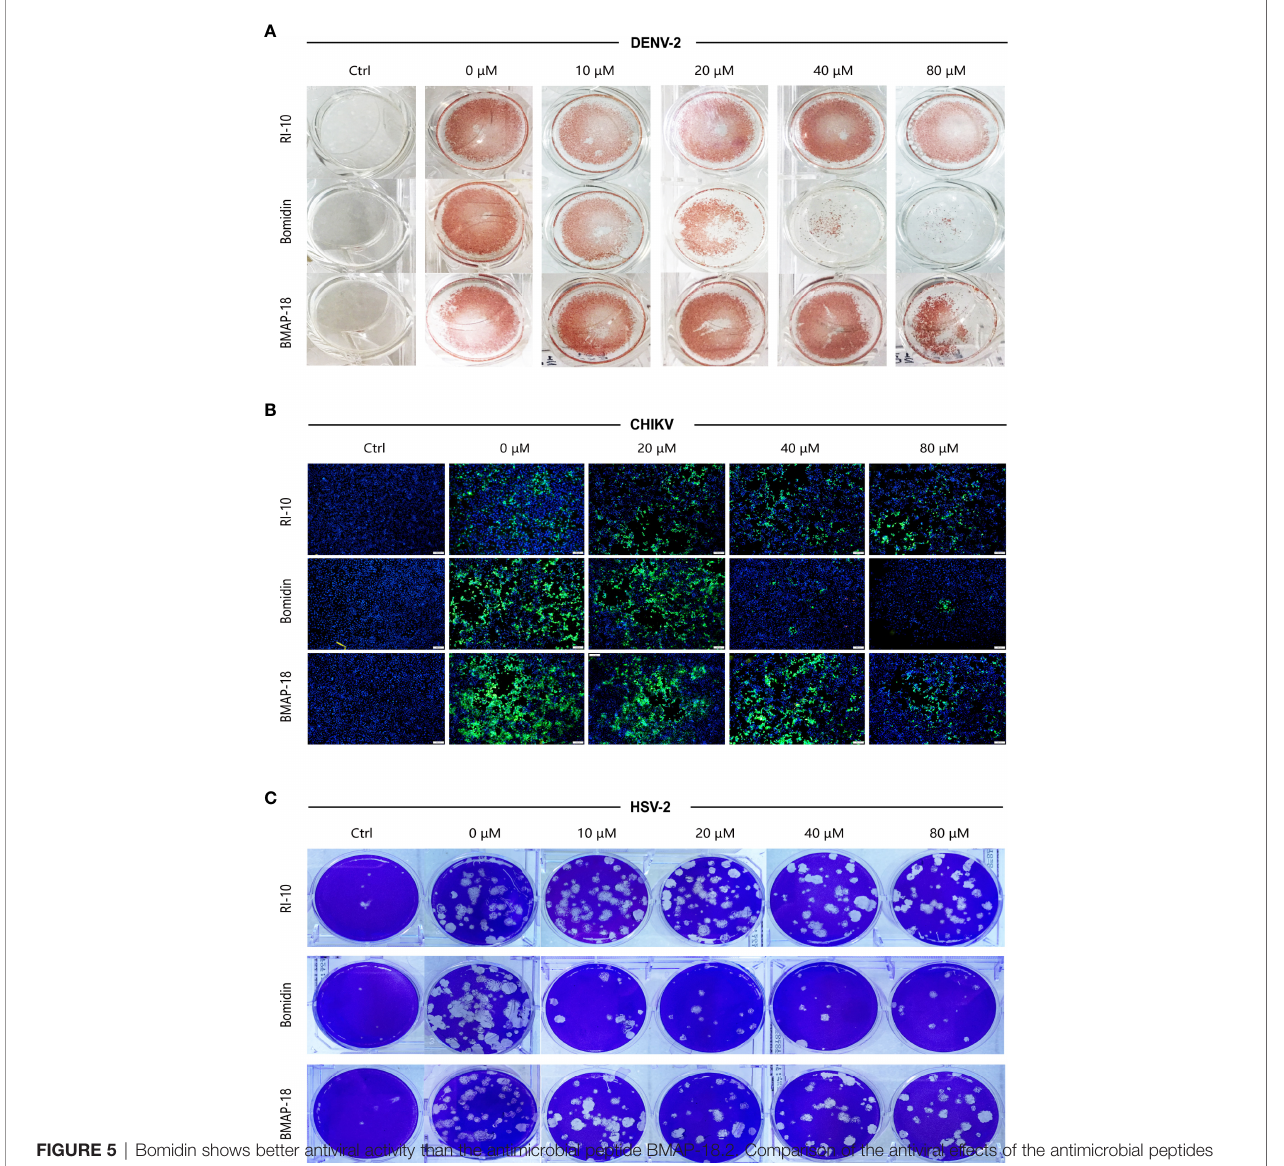
FIGURE 5 | Bomidin shows better antiviral activity than the antimicrobial peptide BMAP-18.2. Comparison of the antiviral effects of the antimicrobial peptides bomidin and BMAP-18 on different viruses. The viruses were mixed with varying concentrations of the antimicrobial peptide to infect cells for 2 h. The effects were detected by various methods (A) fl uorescence focus assay; (B) immuno fl uorescence assay; (C) plaque-forming assay) 48 h postinfection. RI-10: nonantimicrobial control peptide; BMAP-18: antimicrobial control peptide; bomidin: BMAP18-derived antimicrobial